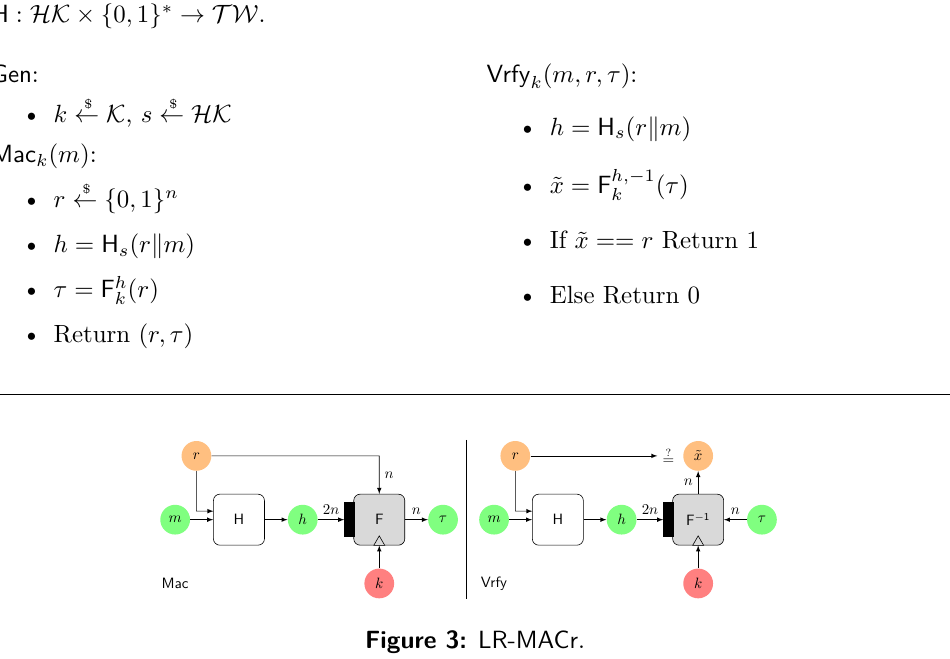
Figure 3: LR-MACr